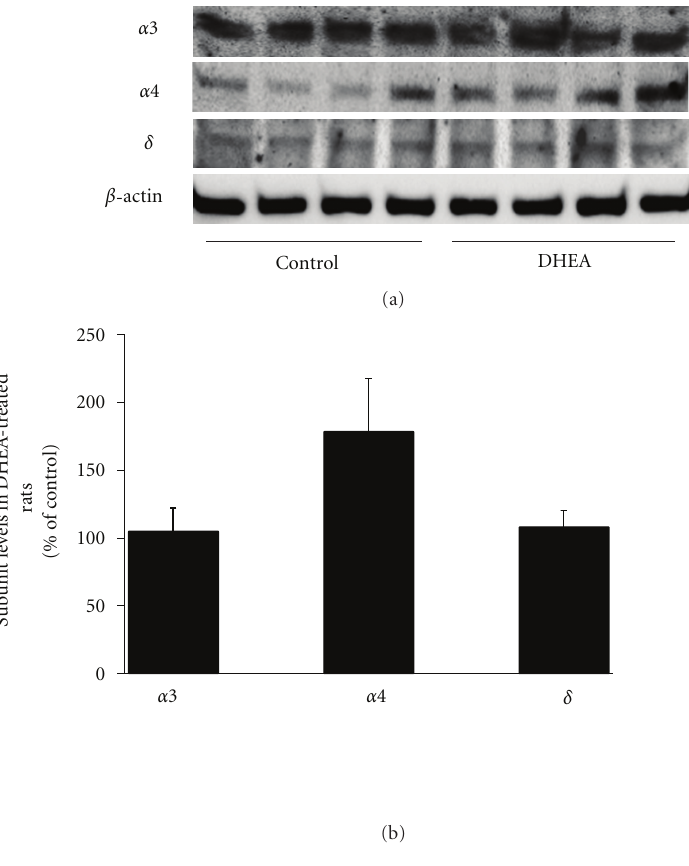
Figure 3: Expression of the α 4, α 3, and δ subunits of GABA A receptors in the hypothalamus of rats administered 56mg/kg of DHEA for 10 consecutive days as measured by Western blot analysis. 100 μ g of tissue from each area was resuspended in lysis bu ff er (20mM Tris pH 8.0, 137mM NaCl, 0.5 mM sodium orthovanadate, 2 mM okadaic acid, 10% glycerol, 1% Nonidet P40, 2% protease inhibitor) and processed for protein extraction using MicroRoto for Lysis Kit (Bio-Rad, Hercules, Calif, USA). The Bradford Method [76] was used to determine protein concentration, and then samples were diluted, separated by SDS-PAGE, and transferred to nitrocellulose PDVF membranes (Amersham Biosciences, Piscataway, NJ, USA). The membranes were immunoblotted for two hours at room temperature with two specific antibodies, a rabbit anti- α 4 antibody at a 1 :500 dilution (Santa Cruz Biotechnology, Santa Cruz, Calif, USA), and a mouse anti- β -actin diluted in a proportion of 1:2000 (Santa Cruz Biotechnology). A specific secondary antibody (PerkinElmer Life Sciences, Waltham, Mass, USA) followed at a dilution of 1:2000. Expression was visualized using ECL Plus (PerkinElmer) and a Fuji Film luminescent image analyzer (LAS-1000 Plus, Fuji Photo Film Co. Ltd., Tokyo, Japan). The images were then quantified by densitometry using the Image Gauge program [77], and the expression value of each subunit was normalized to β -actin